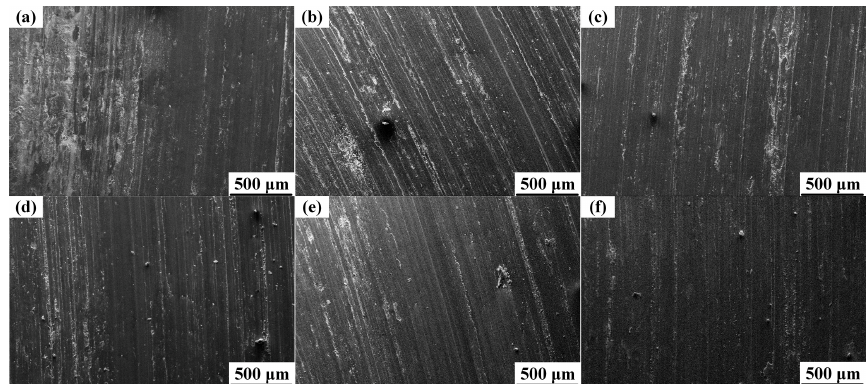
Figure 9. The worn surfaces of ( a ) the Al-Cu matrix alloy and nano-sized TiC p /Al-Cu composite reinforced by different contents of nano-sized TiC p under 20 N load at 180 °C: ( b ) 0.1 wt.%, ( c ) 0.3 wt.%, ( d ) 0.5 wt.%, ( e ) 0.7 wt.% and ( f ) 1.0 wt.%.